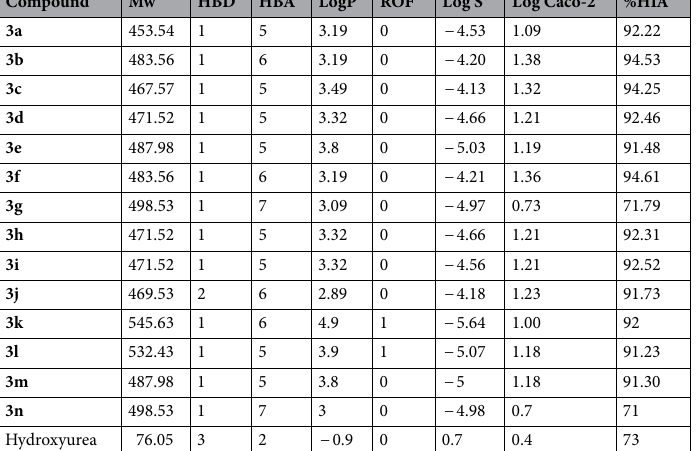
Table 5. Physico-chemical properties of compounds 3a–n . a Number of violations of Lipinski’s rule of five. b Predicted aqueous solubility in mol/l (− 6.5 to 0.5) (QPlogS > − 5.7). c Predicted Caco-2 cell permeability of a given compound is given as the log P app in 10 −6 cm/s (high Caco-2 permeability has LogCaco-2 > 0.9). d Percent of human intestinal absorption, (< 30% is poor and > 30% is